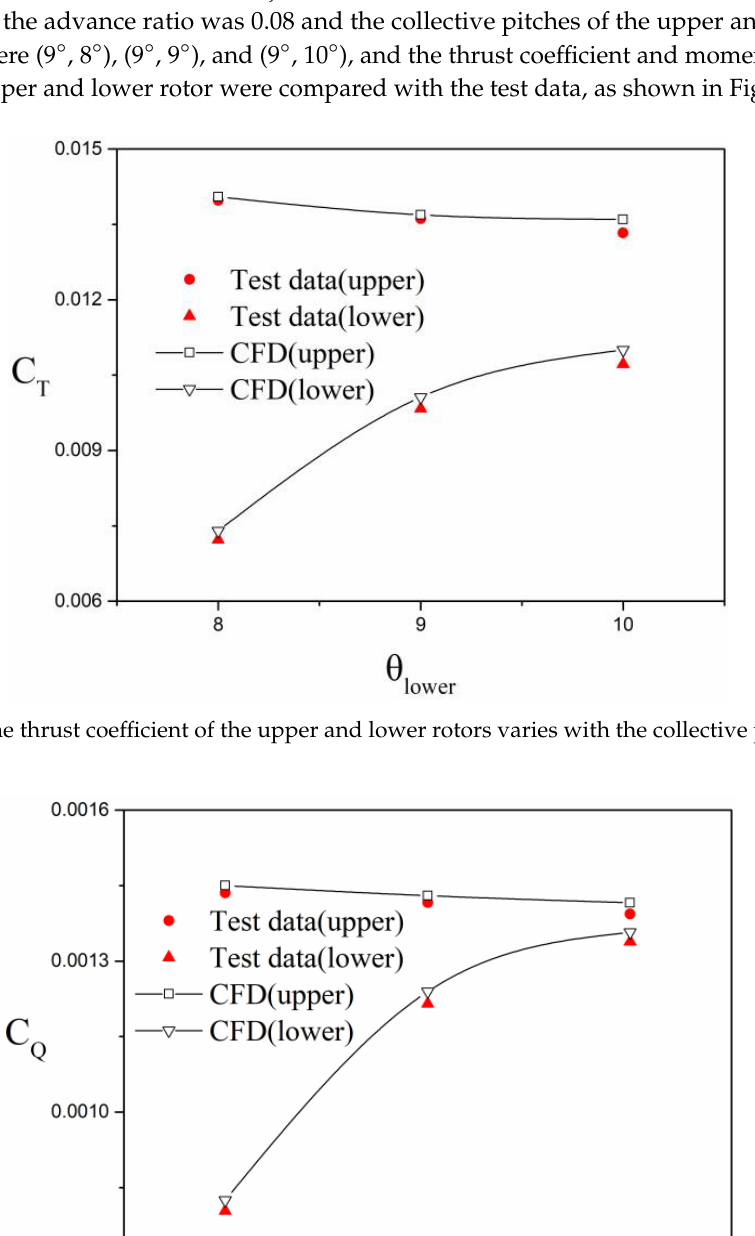
Figure 13. Variation of thrust coefficient and torque coefficient with collective pitch of the coaxial rotor in hover.